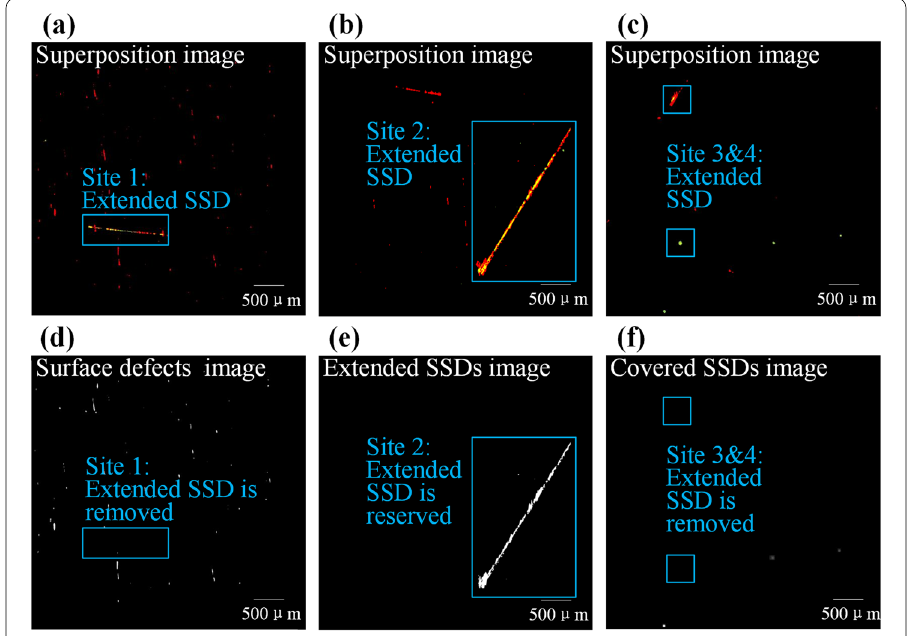
Fig. 6 Extraction results of three types of defects. a b c Superposition images of three sites. d Surface